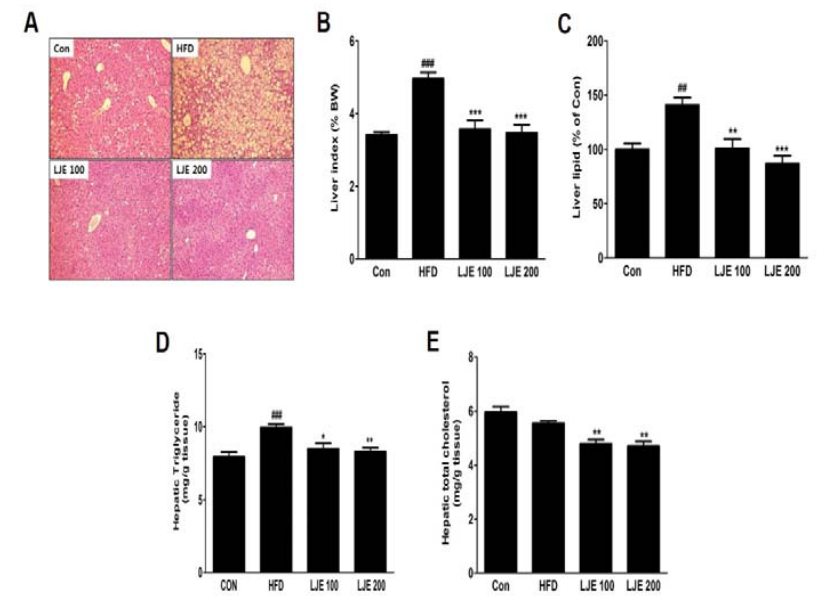
Figure 7. Effects of LJE on liver steatosis in HFD-fed mice. ( A ) Liver sections stained with hematoxylin and eosin (100×); ( B ) Liver index; ( C ) Liver lipid content; ( D ) Hepatic triglyceride levels; ( E ) Hepatic total cholesterol levels. Con, normal control diet; HFD, high-fat diet; LJE 100, HFD plus LJE (100 mg/kg, peroral); LJE 200, HFD plus LJE (200 mg/kg, peroral). Data represent means ± SEM ( n = 8). ## p < 0.01, ### p < 0.001 vs. Con; * p < 0.05, ** p < 0.01, *** p < 0.001 vs.